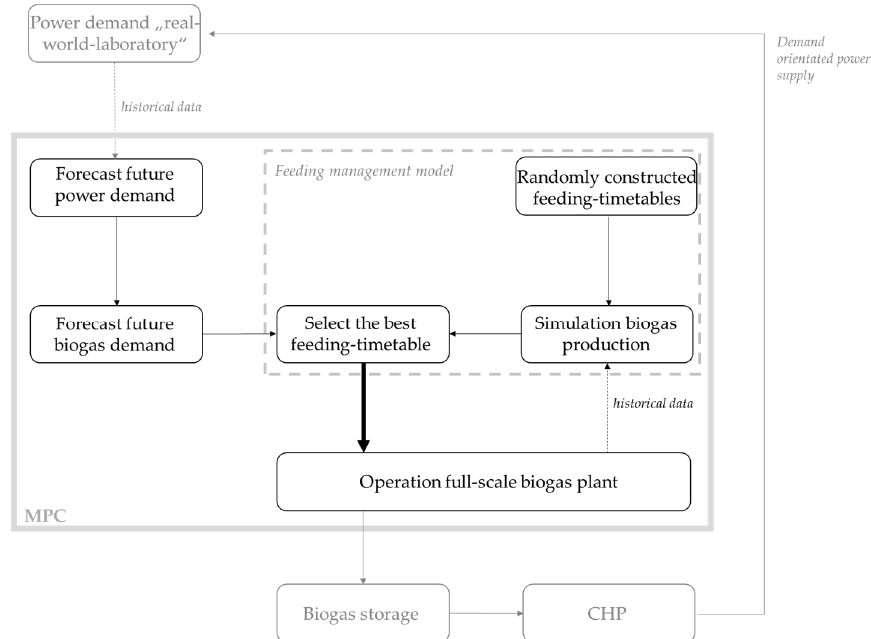
Figure 1. Schematic representation of the model predictive control (MPC) with showing and classifying the three key components: forecast of future power demand, forecast of biogas demand, feeding management model.